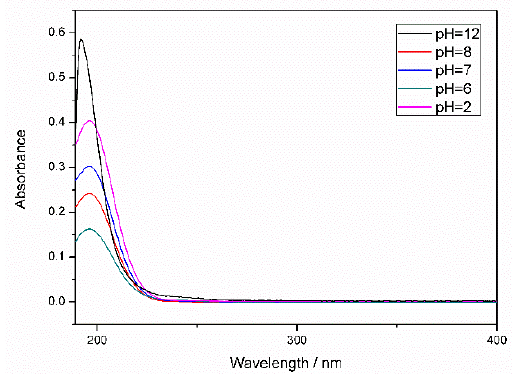
Figure 9. The UV-Vis spectra of FCMSs in acidic, alkaline and neutral suspensions.